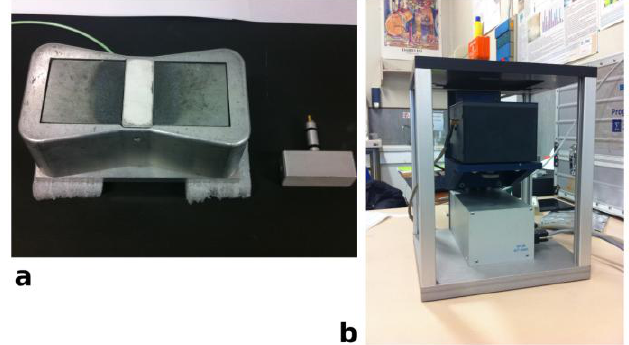
Figure 1. ( a ) Unilateral NMR sensor by Bruker Biospin; ( b ) NMR sensor with a uniform gradient to resolve the near surface structure of arbitrarily large samples, the sensor is placed on a lift that allows one to move the magnetic field inside the object to be analyzed with micrometric steps, sensor by RWTH Aachen University, Aachen, Germany